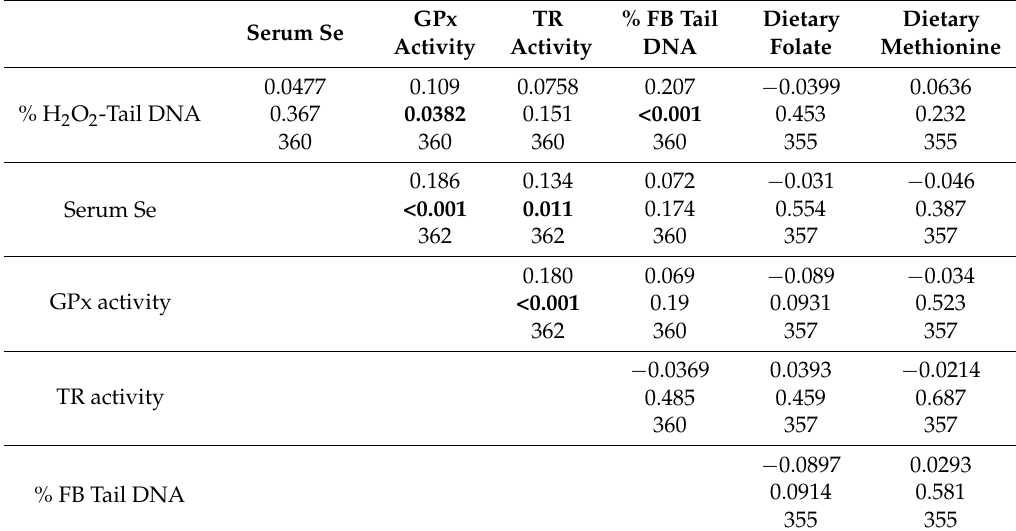
Table 5. Baseline correlations between parameters assessed for complete